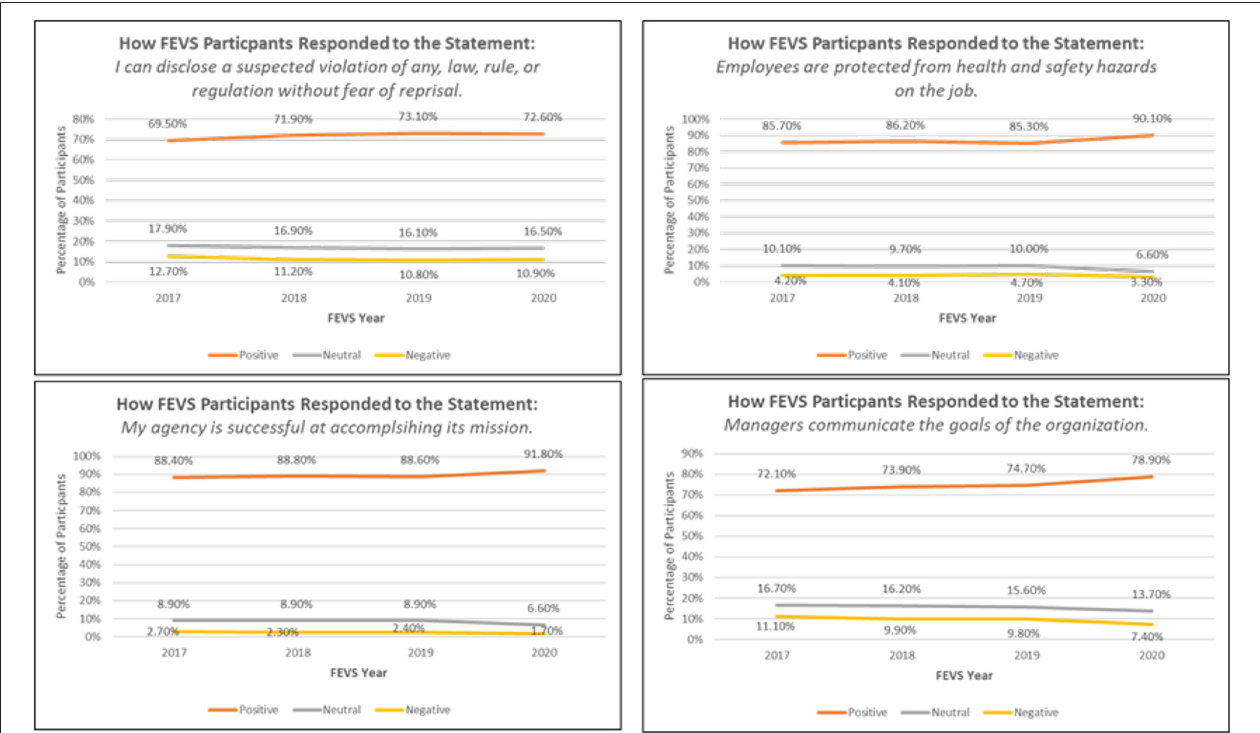
FIGURE 1 | FEVS results for 2017–2020 for risk culture questions (Data visuals created by